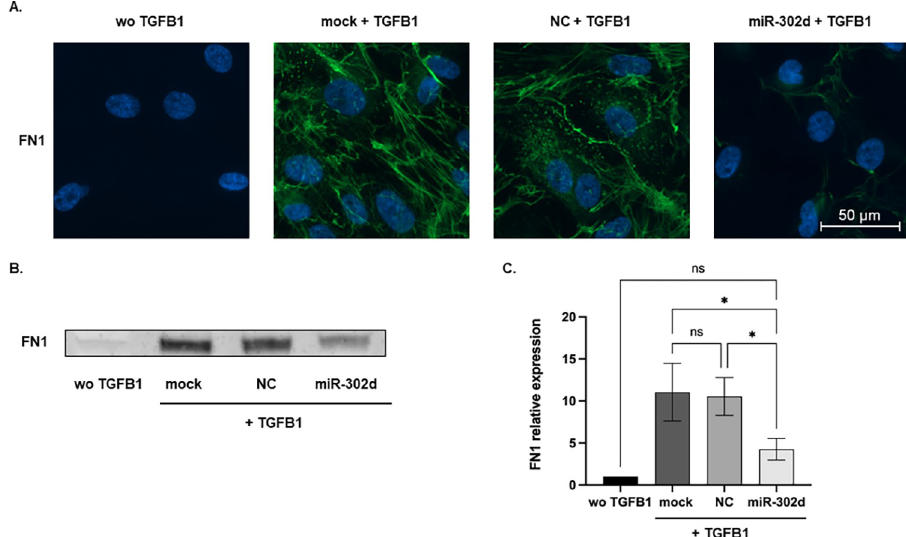
Fig 4. miR-302d suppresses TGFB-induced production of FN1. (A) ICC staining and (B) representative Western blot of FN1 in transfected hRPE cells after 3 d incubation of TGFB1. The scale bar represents 50 μ m. (C) The relative expression of FN1 normalized to total proteins (S1 Raw images). The values were further normalized to the "wo TGFB1" group. One-way ANOVA with Tukey’s multiple comparisons tests (n = 3) were performed. The error bars represent SD. ns, non-significant, � p < 0.05.